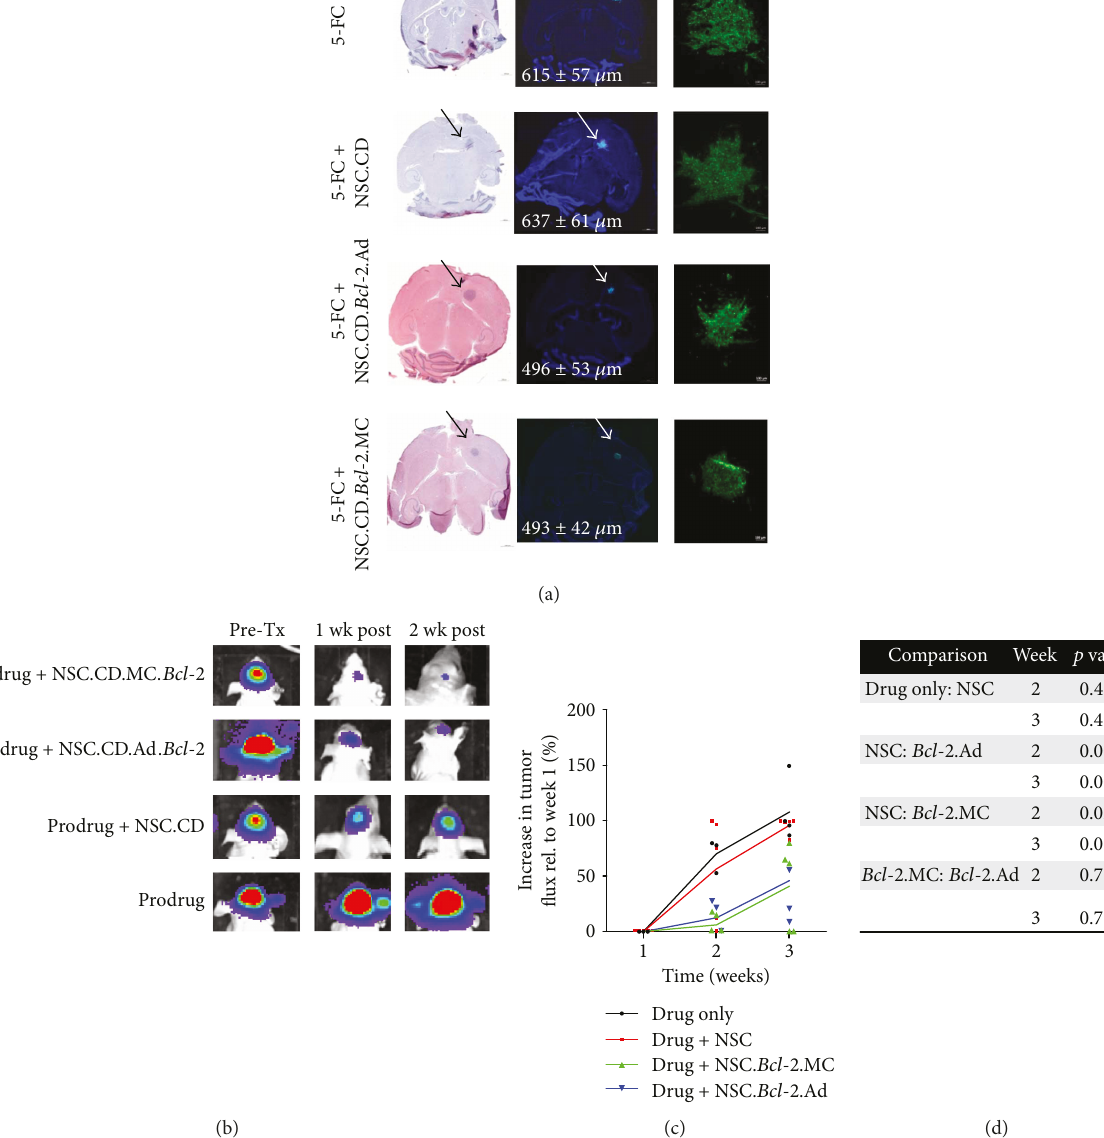
Figure 4: Therapeutic advantage of Bcl-2 expression in NSCs. (a) Representative brain sections showing the relative sizes of U251.eGFP. ffl uc tumor 3 weeks after coimplantation with either parental or transduced/transfected NSC.CDs. All groups received 500 mg/kg of the prodrug 5- FC. Brain slices with the maximal tumor surface area are shown stained with H&E (left panel) and DAPI (center panel). In the fl uorescent DAPI images, eGFP +tumor cells are visible (green). Arrows indicate tumor location. Average maximum tumor diameter is provided in white text. (b) Representative bioluminescent images of ffl uc-expressing U251 glioma cells at select time points after coimplantation with either parental or transduced/transfected NSC.CDs. (c) Quanti fi cation of bioluminescent tumor fl ux in all animals (mean+ individual datapoints shown). (d) Bioluminescent imaging p value table showing MC. Bcl-2 and Ad. Bcl-2 treatment groups achieved a statistically signi fi cant reduction in tumor bioluminescent fl ux